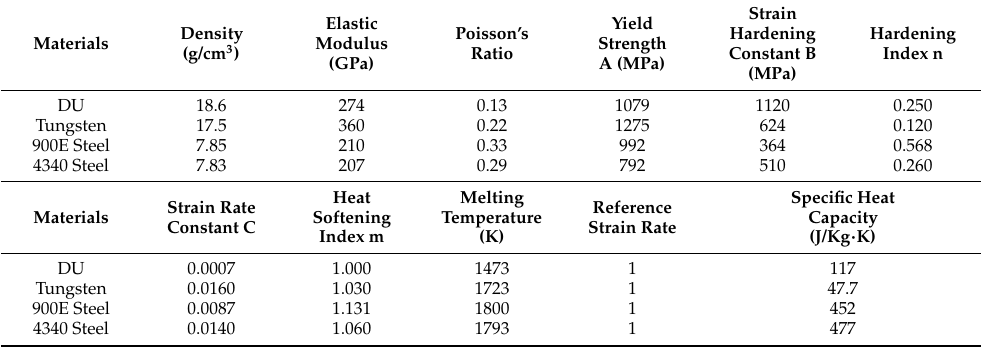
Figure 1. FEM-SPH coupling simulation model between bullet and target. ( a ) quarter model; ( b ) whole model. Table 1. Material parameters of constitutive models of different alloys.